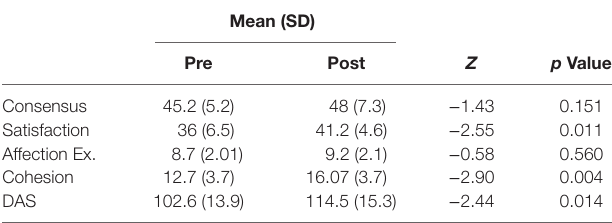
TaBle 3 | Comparison of total and subscale DAS scores in baseline and final sessions.